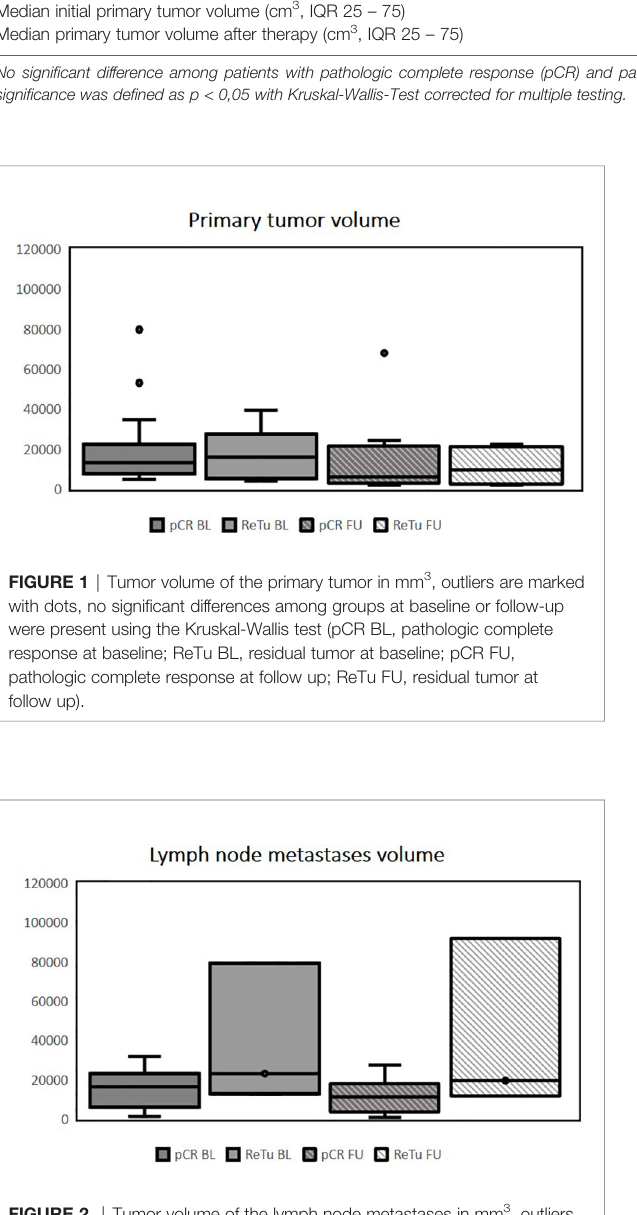
FIGURE 2 | Tumor volume of the lymph node metastases in mm 3 , outliers are marked with dots, no signi fi cant differences among groups at baseline or follow-up were present using the Kruskal-Wallis_test (pCR BL, pathologic complete response at baseline; ReTu BL, residual tumor at baseline; pCR FU, pathologic complete response at follow up; ReTu FU, residual tumor at follow up). In the pCR group 9 patients showed lymph node metastases, in the ReTu group in 3 patient lymph node metastases were present.